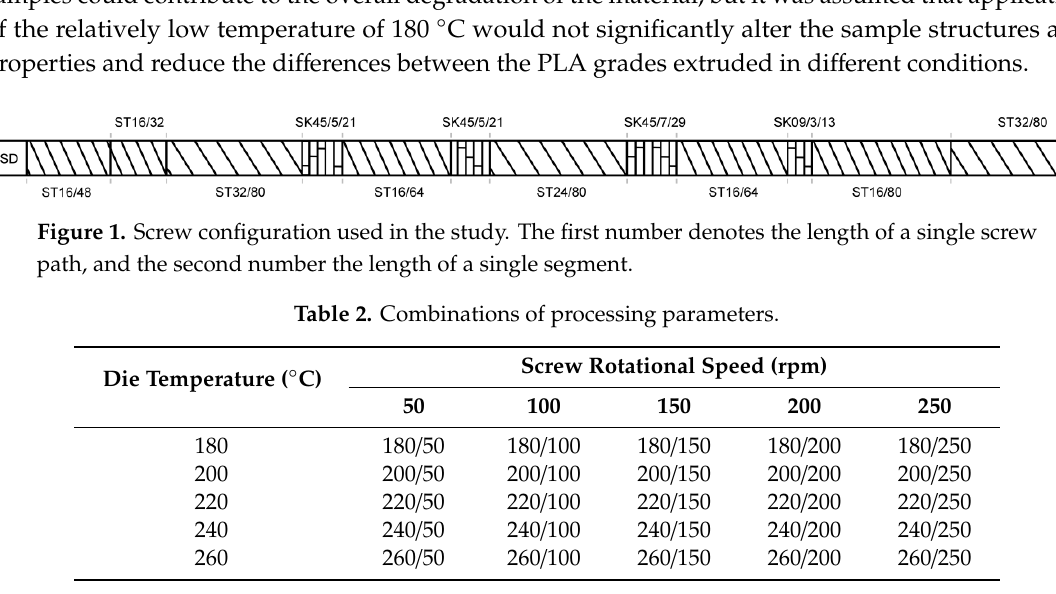
Table 3. Temperature profiles used during extrusion corresponding to die in various maximum temperature setups.